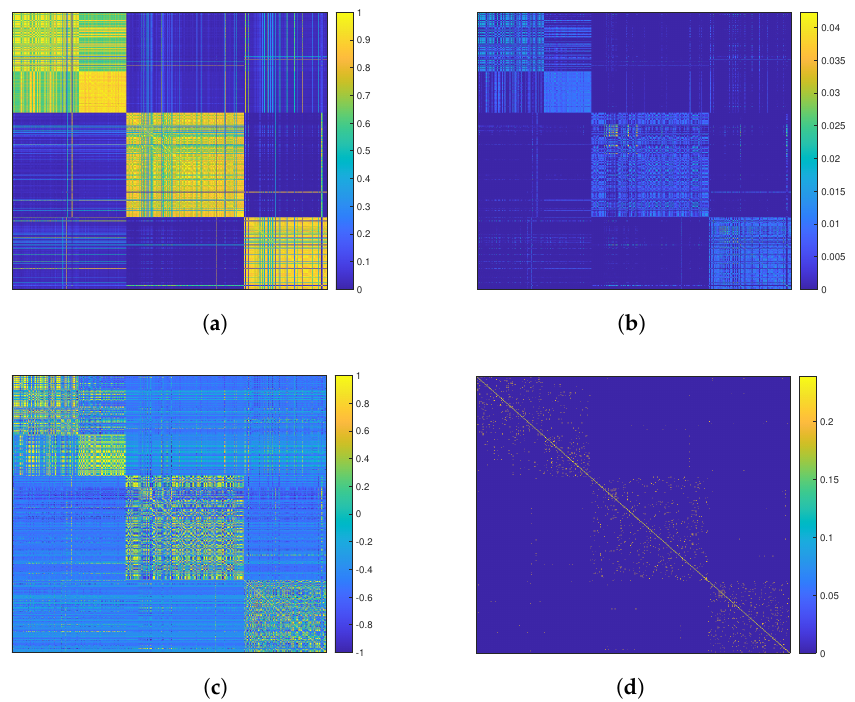
Figure 3. Illustrations of the clustering structure in the learned consensus matrices from different methods on the CSTR data set. ( a ) is the mean of the input similarity matrix S . ( b , c ) Learned consensus matrices by the robust methods MEC and RSEC. ( d ) is our LSWCEH method. Note that our method of learned consensus is sparse. Each sample is connected to only a finite number of points, and our method separates clusters more clearly. Table 3. Clustering results measured by the accuracy of the compared